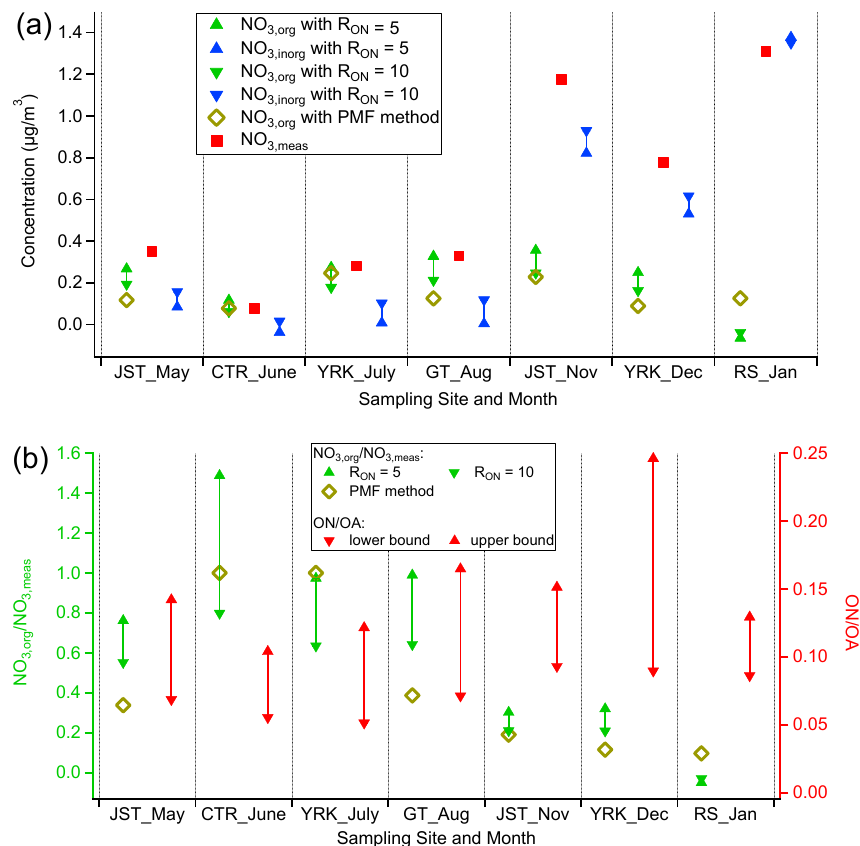
Figure 10. (a) Concentrations of total measured NO 3 (i.e., NO 3 , meas ), estimated “nitrate functionality from organic nitrates” (i.e., NO 3 , org ) by the NO + x ratio method and the PMF method. (b) The contribution of NO 3 , org to NO 3 , meas (i.e., NO 3 , org / NO 3 , meas ) from the NO + x ratio method and the PMF method. Also shown are the estimated contribution of organic nitrates to total OA from the “best estimate” range of NO 3 , org and by assuming a molecular weight of 200 and 300gmol − 1 for organic